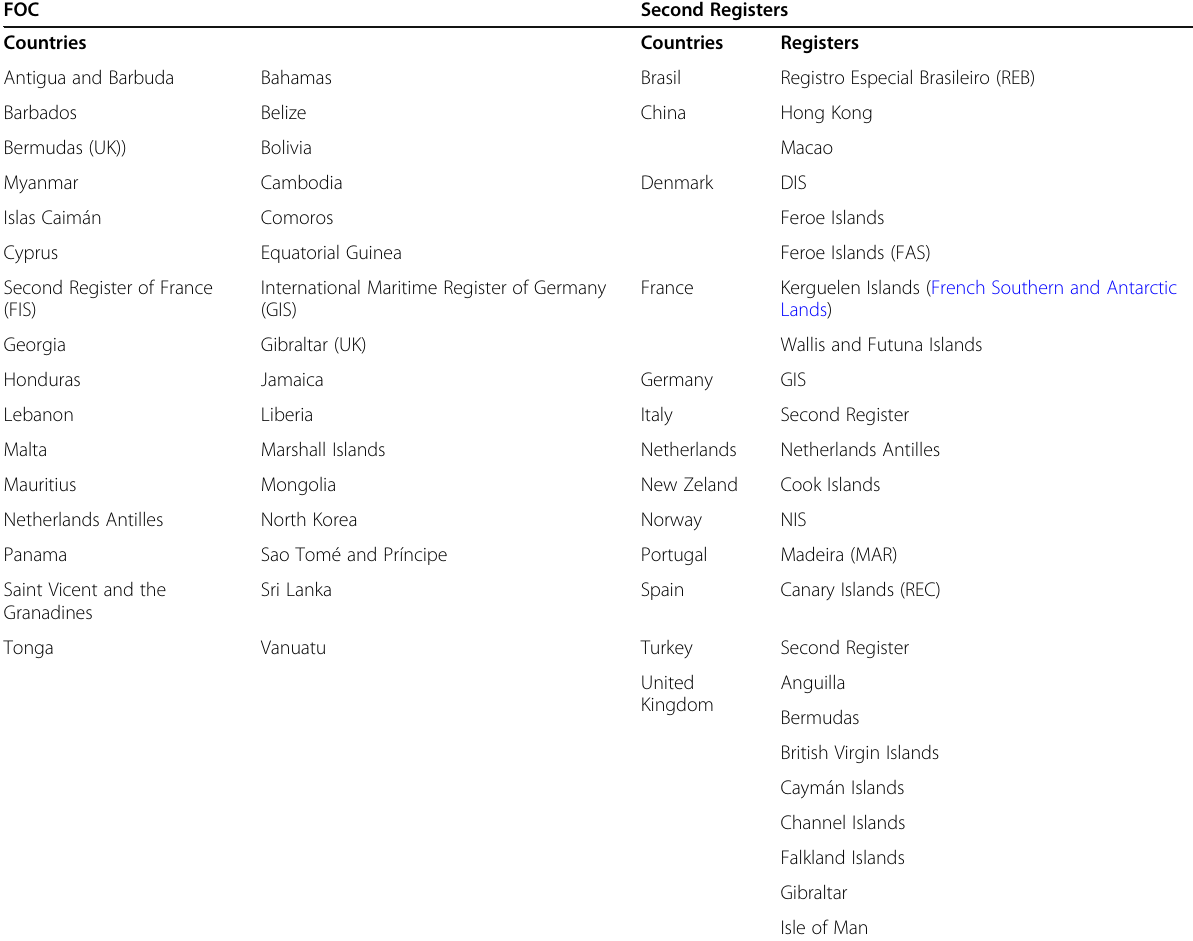
Table 1 Countries that offered FOC and second register services in